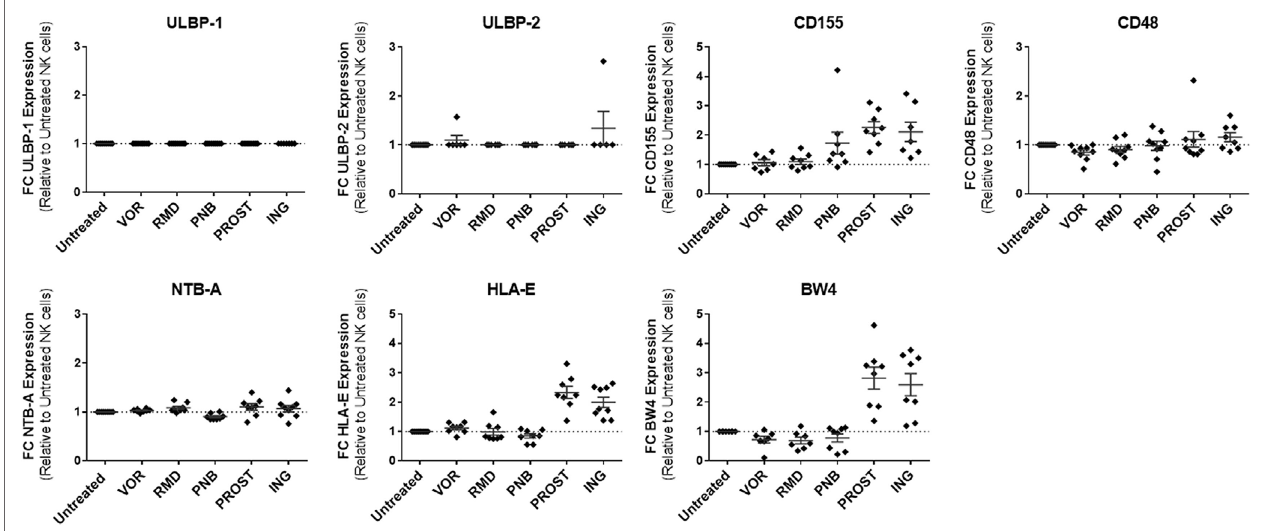
FigUre 7 | nK ligand expression on resting cD4 + T cells in the presence of lras . LRAs had little effect on NK ligand expression with the exception of PKC agonists, which caused increased expression of the inhibitory NK ligands HLA-E and HLA-Bw4 as well as activating ligand CD155. Median fluorescence intensity was compared to the medium/carrier solvent alone condition (negative control, dimethyl sulfoxide). N =